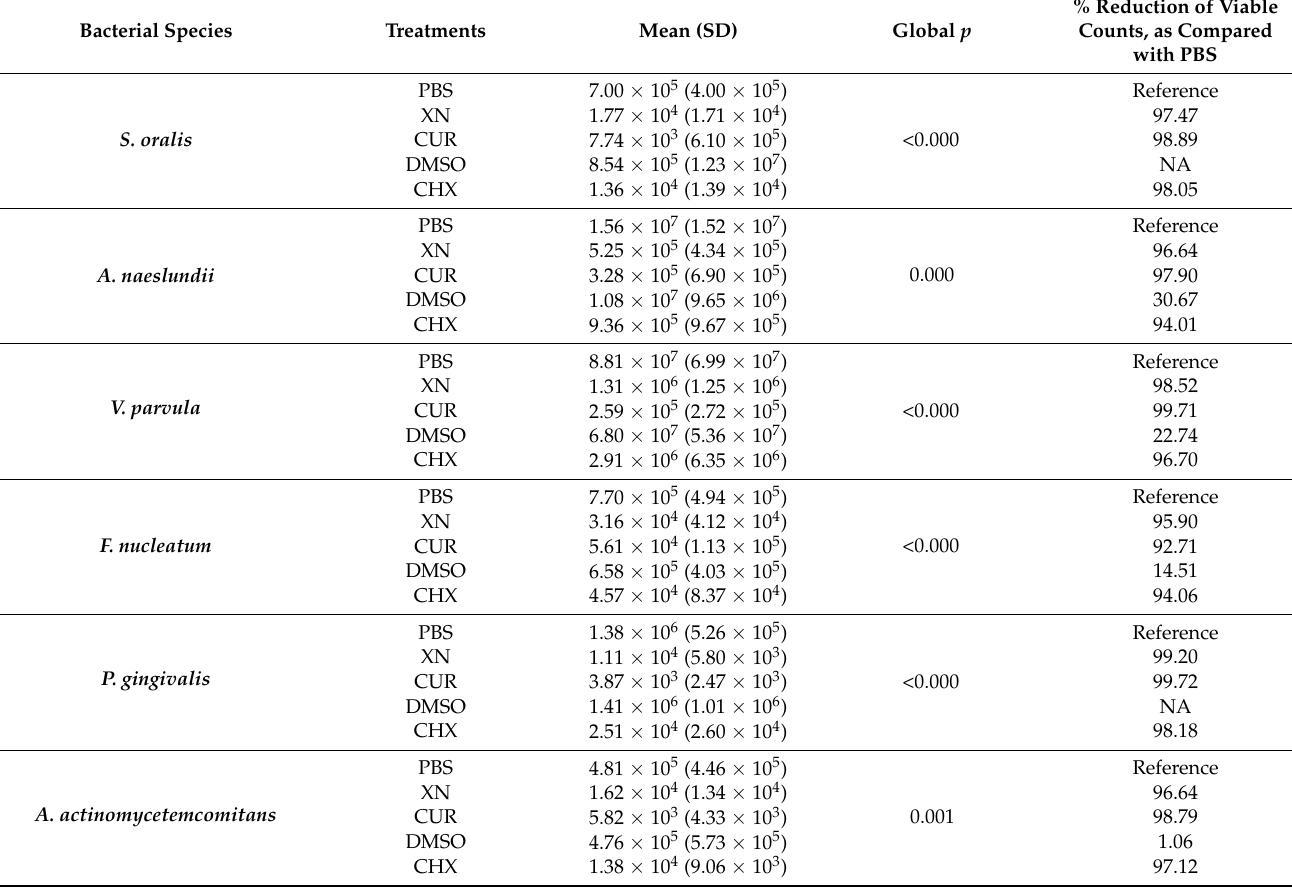
Table 1. Antibacterial effects of curcumin (CUR) and xanthohumol (XN), as observed in the mean number of viable bacteria counts [colony forming units per mL (CFUs) mL − 1 , determined by qPCR], evaluated in an in vitro multi-species dynamic biofilm model. Data are expressed as mean and standard deviation (SD). Differences are considered statistically significant at p < 0.05.